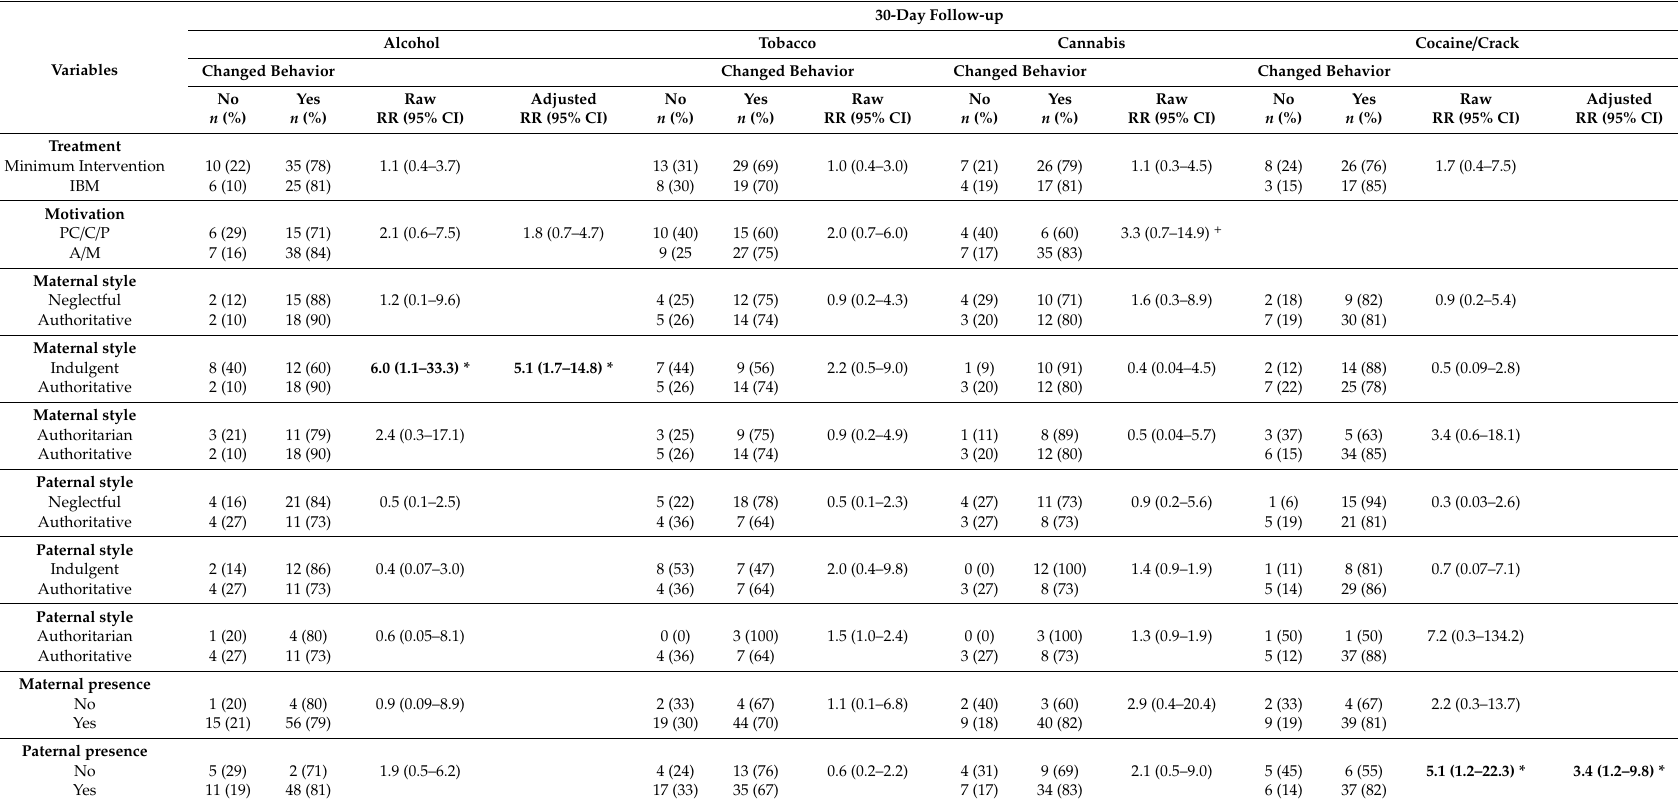
Table 3. Relative Risk (RR) for substance use behavior change in the 30-day